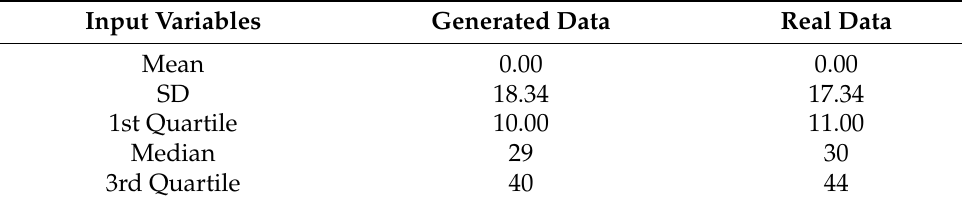
Table 5. Comparing statistical summary of datasets.